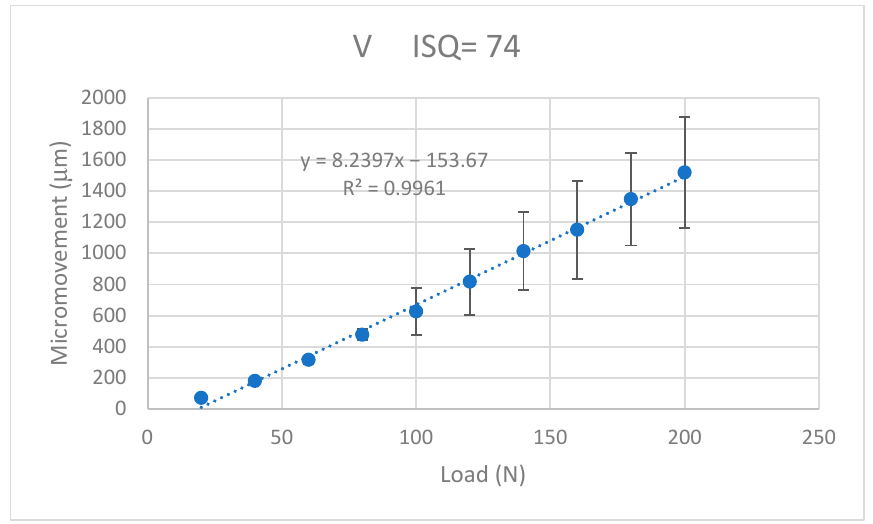
Figure 12. Micromovements in micrometers associated with the load in N for the V implants.